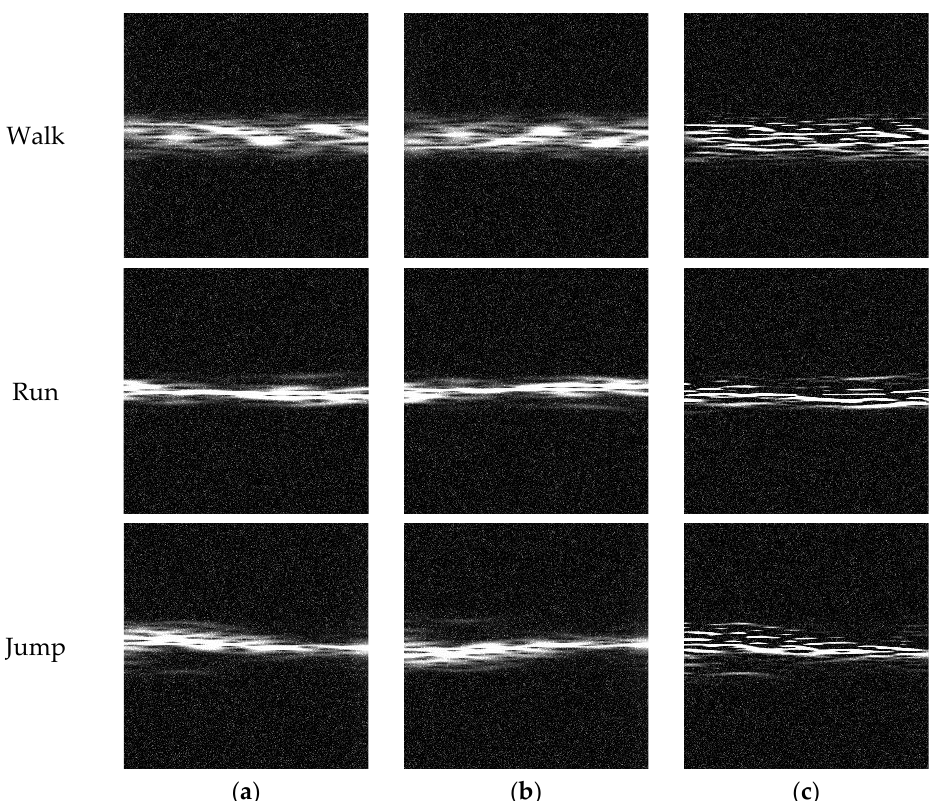
Figure 15. Generated samples obtained by the affine+sharpening method using the modified Boulic model. ( a ) The original image; ( b ) affine (reflex); ( c ) sharpening.